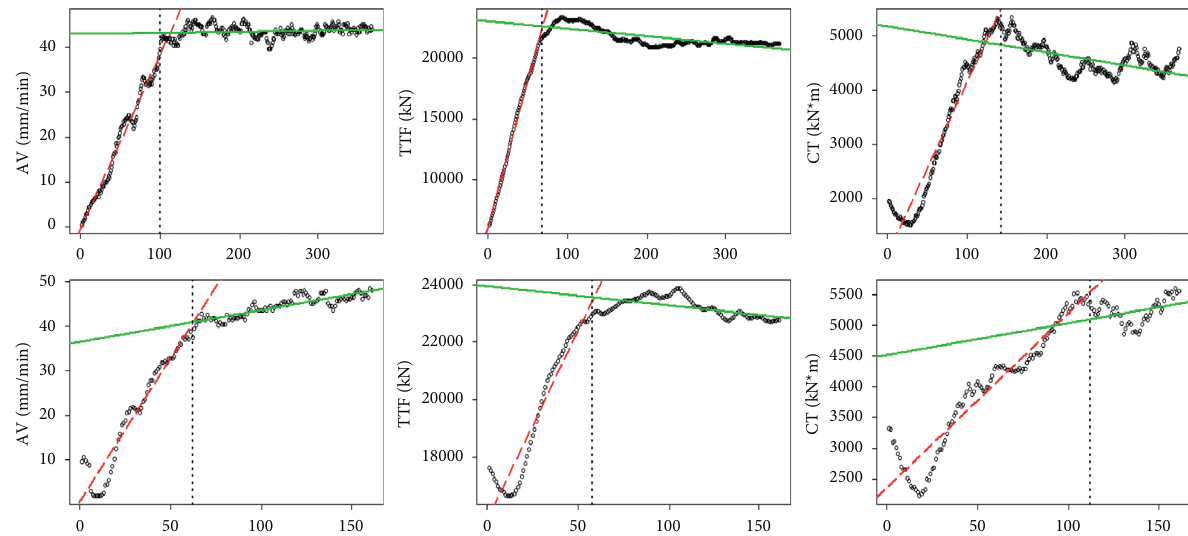
Figure 4: The regression model fitting of the first two normal tunneling data sections in Ring Table 1: Correlation coefficient matrix of some key operation parameters based on the start-up dataset. CRS AV PPA